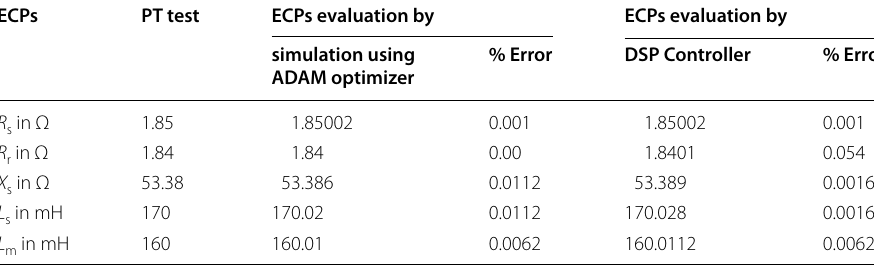
Table 5 ECPs obtained from the DSP-based controller ECPs PT test ECPs evaluation by ECPs evaluation by simulation using % Error DSP Controller % ADAM optimizer